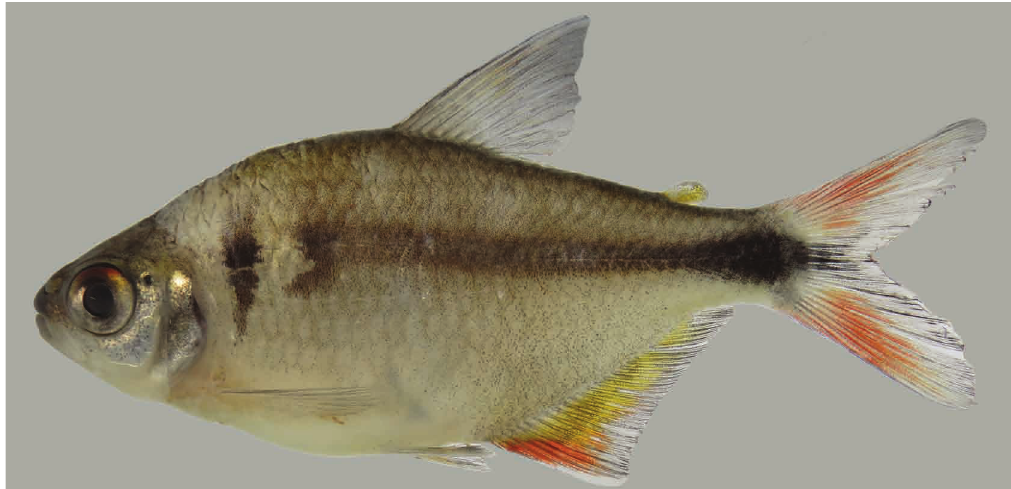
Fig. 1. Astyanax bagual , UFRGS 19525, 74.1 mm SL, male, holotype, rio Carreiro downstream to hydroeletric plant